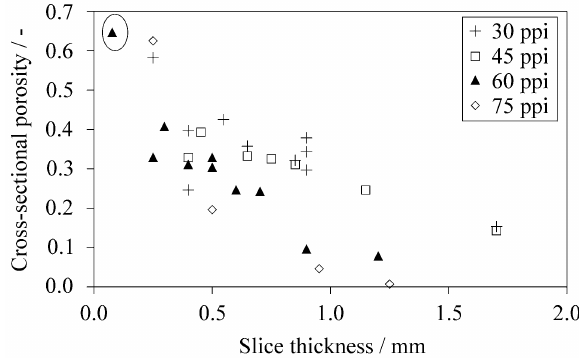
Figure 4. Influence of slice thickness on the mean pore size of SiC-Al 2 O 3 ceramic foams with 30 to 75 ppi. Circled symbol refers to the CT-image value.